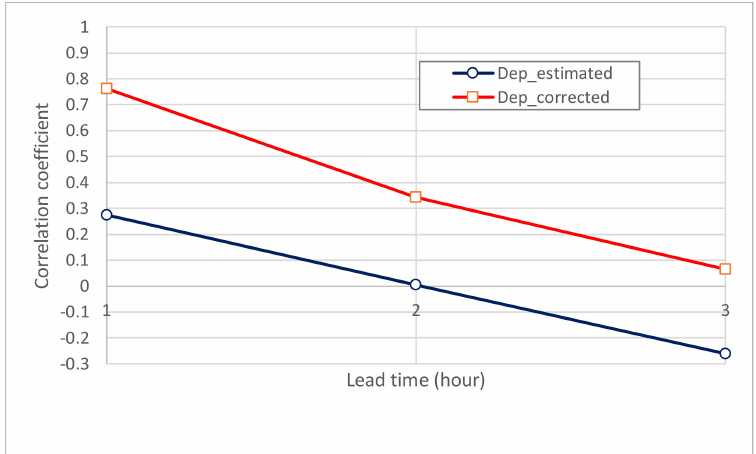
Figure 17. Summary of the performance indices of the inundation-depth estimates and the corre- sponding corrections for the validated rainfall-induced flood